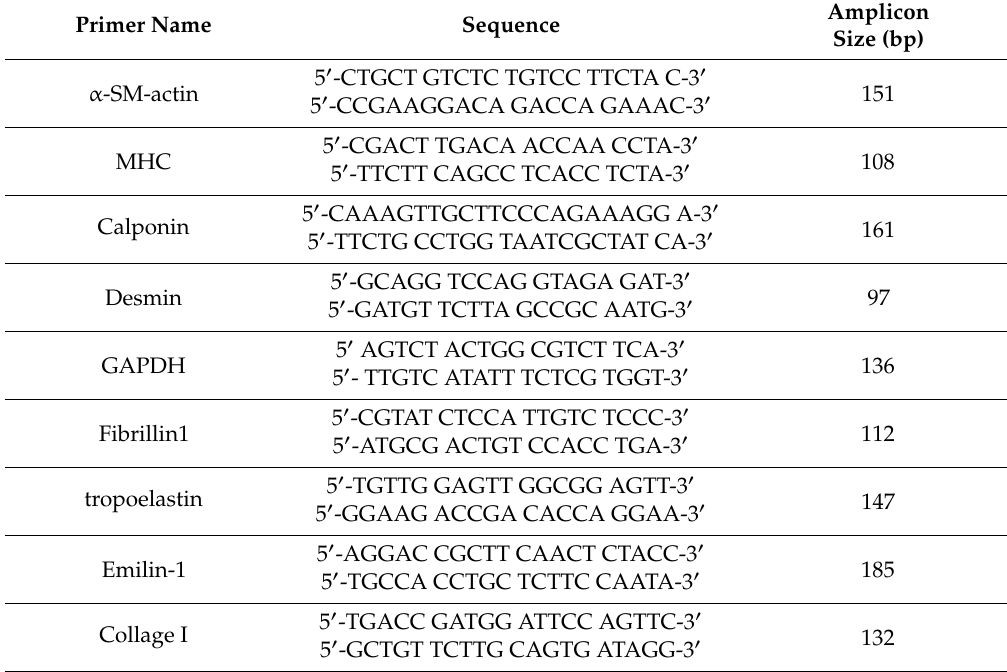
Table 1. Primer sequences used in real-time-polymerase chain